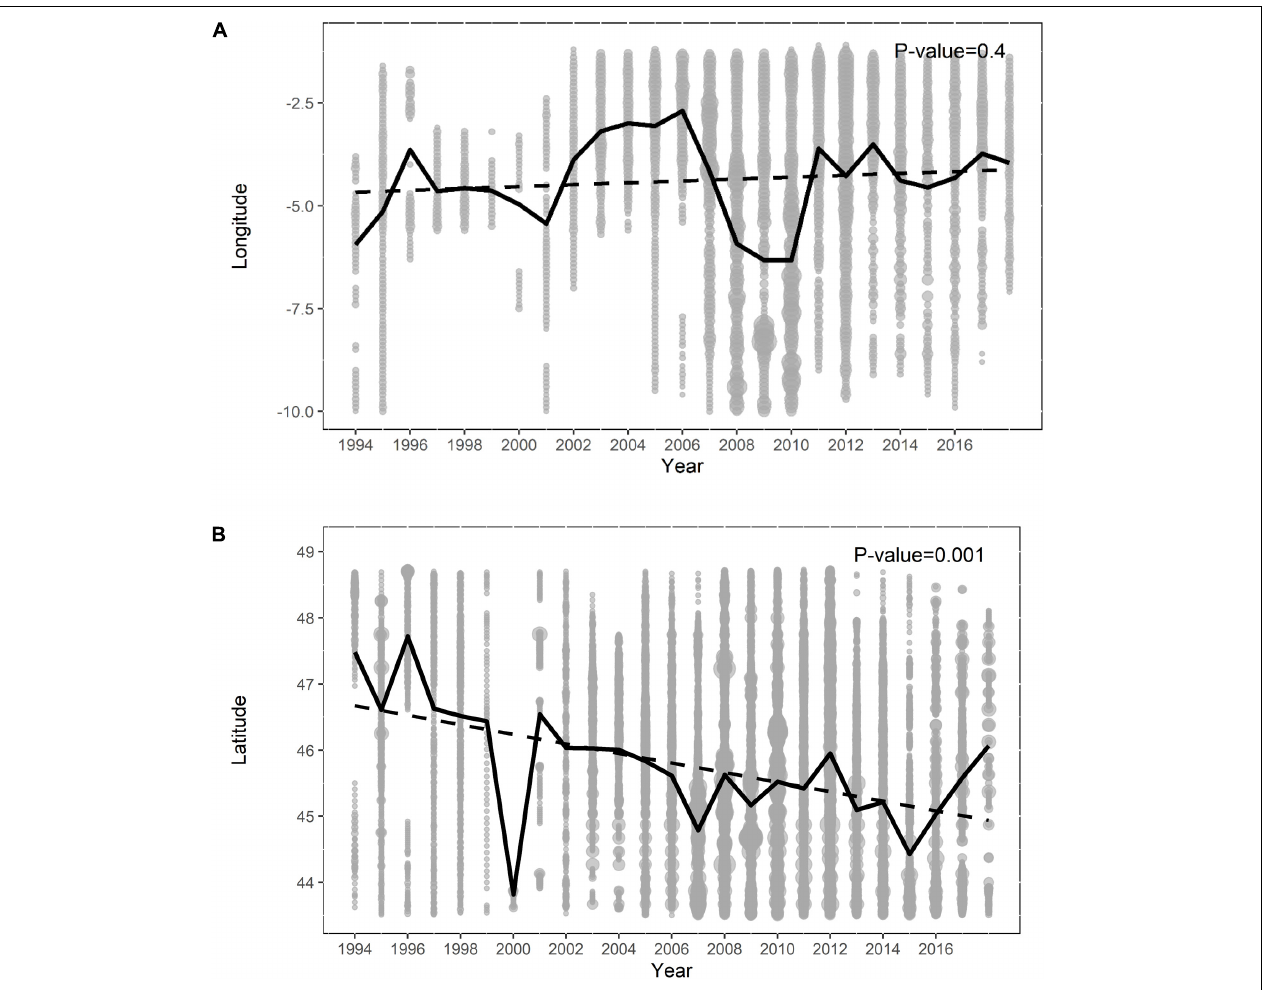
FIGURE 2 | Sampling effort (number of segments of up to 10 km) as a function of year and longitude (A) , and year and latitude (B) . In both figures the size of the circle is proportional to the sampling effort; the black line indicates the mean value and the dotted line the linear temporal